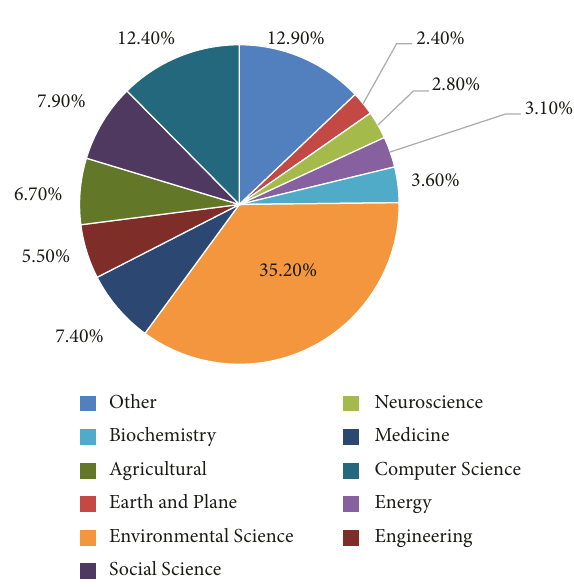
Figure 22: Pie chart depicting article distribution by disciplines for systematic map